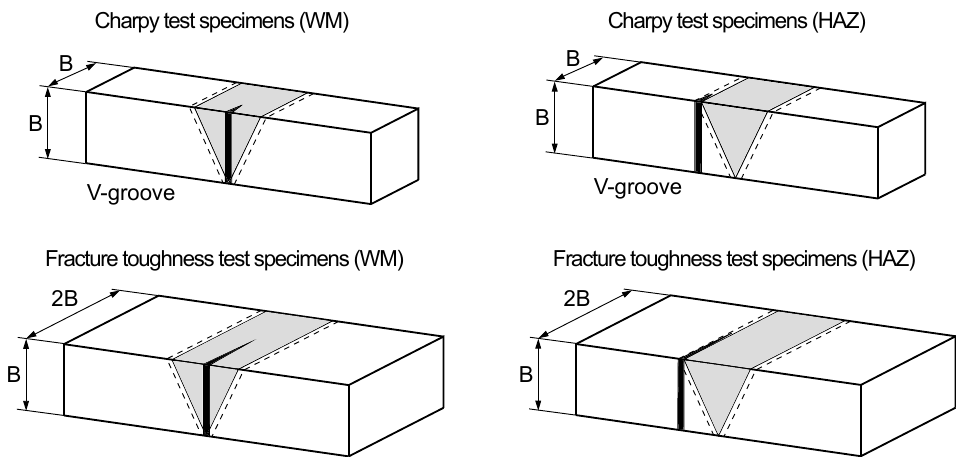
Figure 9. Charpy and fracture toughness test specimens with the notch and crack tip located in the HAZ (heat-affected zone) or WM (weld